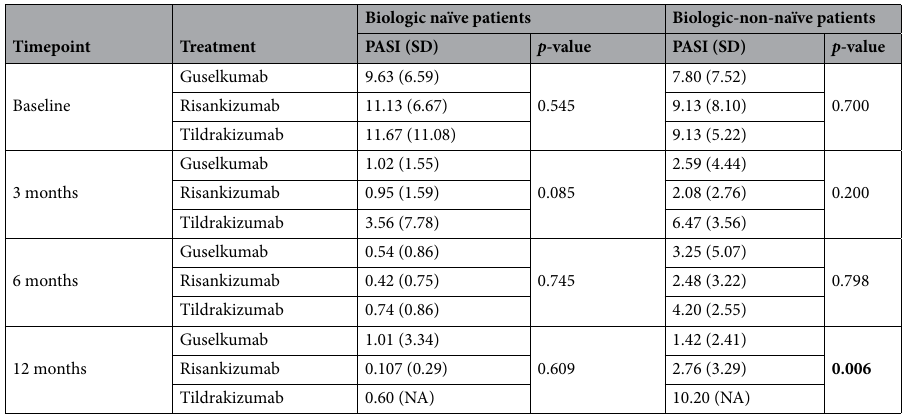
Table 3. Treatment effectiveness as observed regarding biologic naivety in patients treated with different IL-23 inhibitors. Analysis of variances revealed no statistically significant differences in PASI for any timepoint among biologic-naïve or -non-naïve patients with regard to the administered drug, except for PASI at 12 months in biologic-non-naïve patients. However, post hoc analysis was not feasible due to the low number of patients at 12 months in the tildrakizumab group ( n = 2). Significant p -values are bold. NA, not applicable (none); PASI, Psoriasis Area and Severity Index; SD, standard deviation.